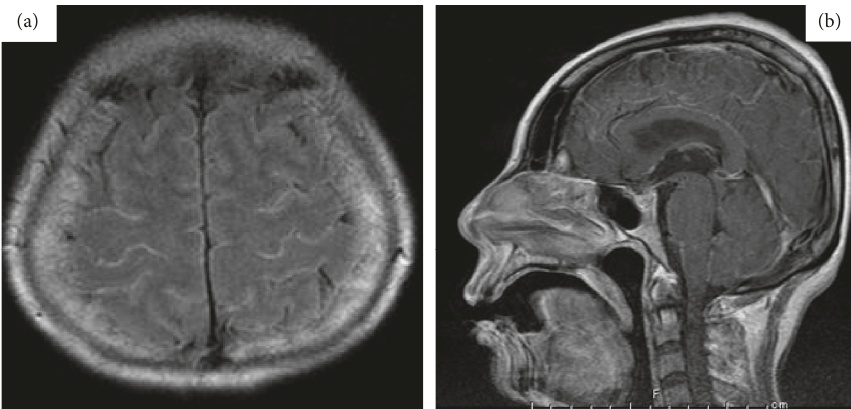
Figure 6: (a, b) Fluid-attenuated inversion recovery (FLAIR) magnetic resonance imaging of the brain revealed pia-subarachnoid en- hancement (case